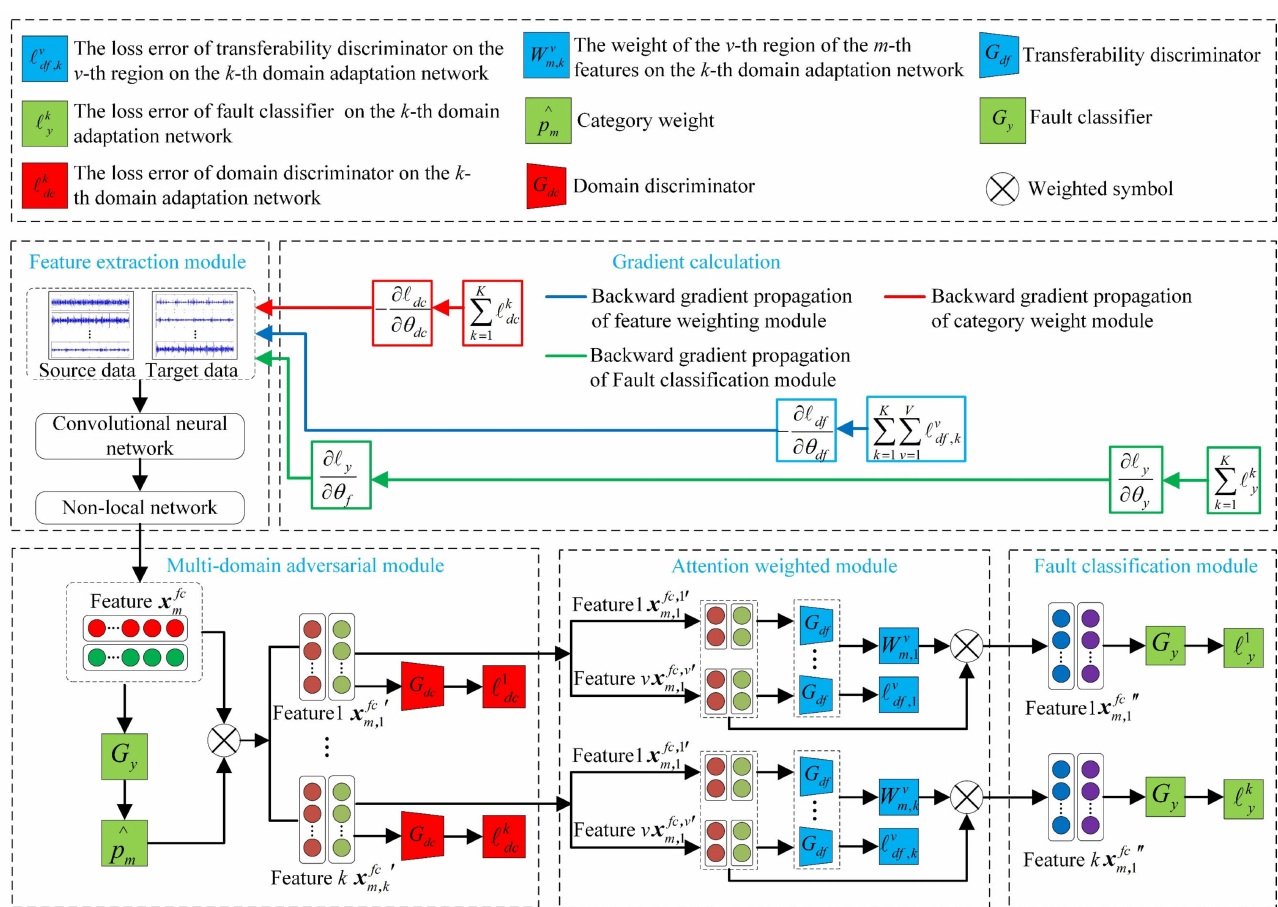
Figure 2. The structure of the proposed